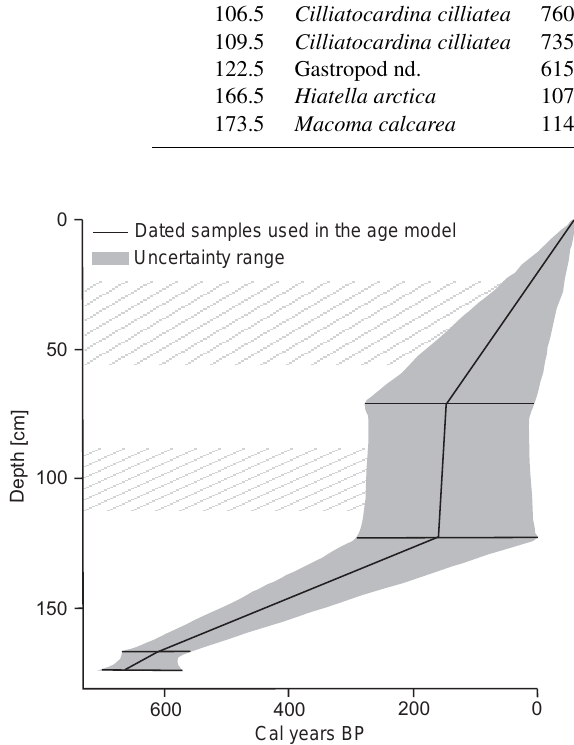
Figure 2. Age model of the studied core. The black line indicates the age–depth model derived from a linear interpolation. The grey fields show the probability distributions of calendar dates obtained by the calibration of individual 14 C dates used for the age model. The shaded areas mark sediment intervals which most likely repre- sent major redeposition events (after Pawłowska et al., 2014, modi-